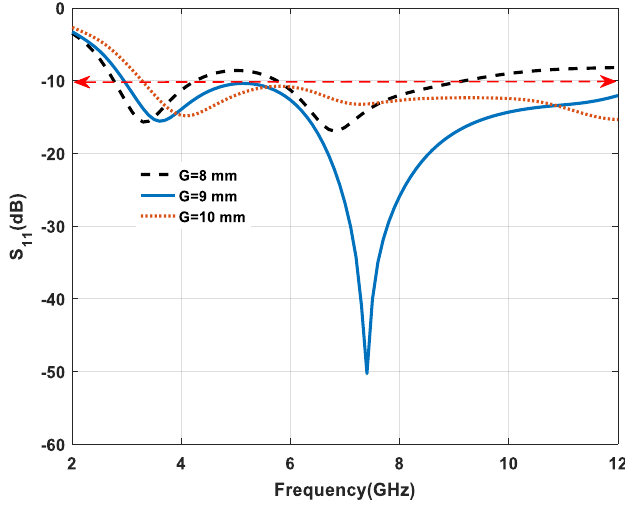
Figure 6. Effect of variation on a ground plane.